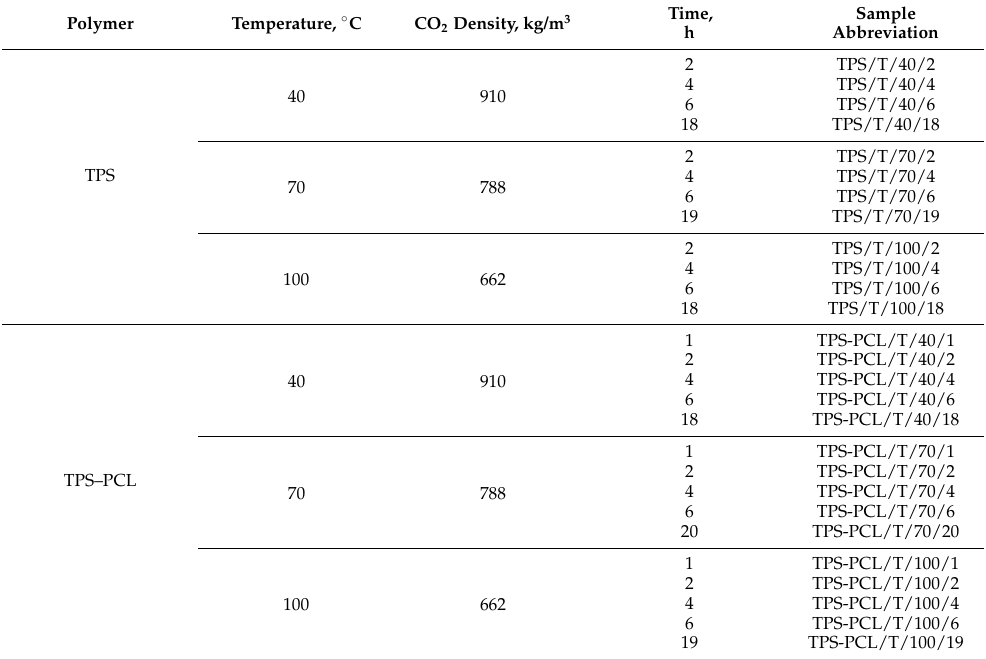
Table 1. List of samples impregnated with thymol (T).